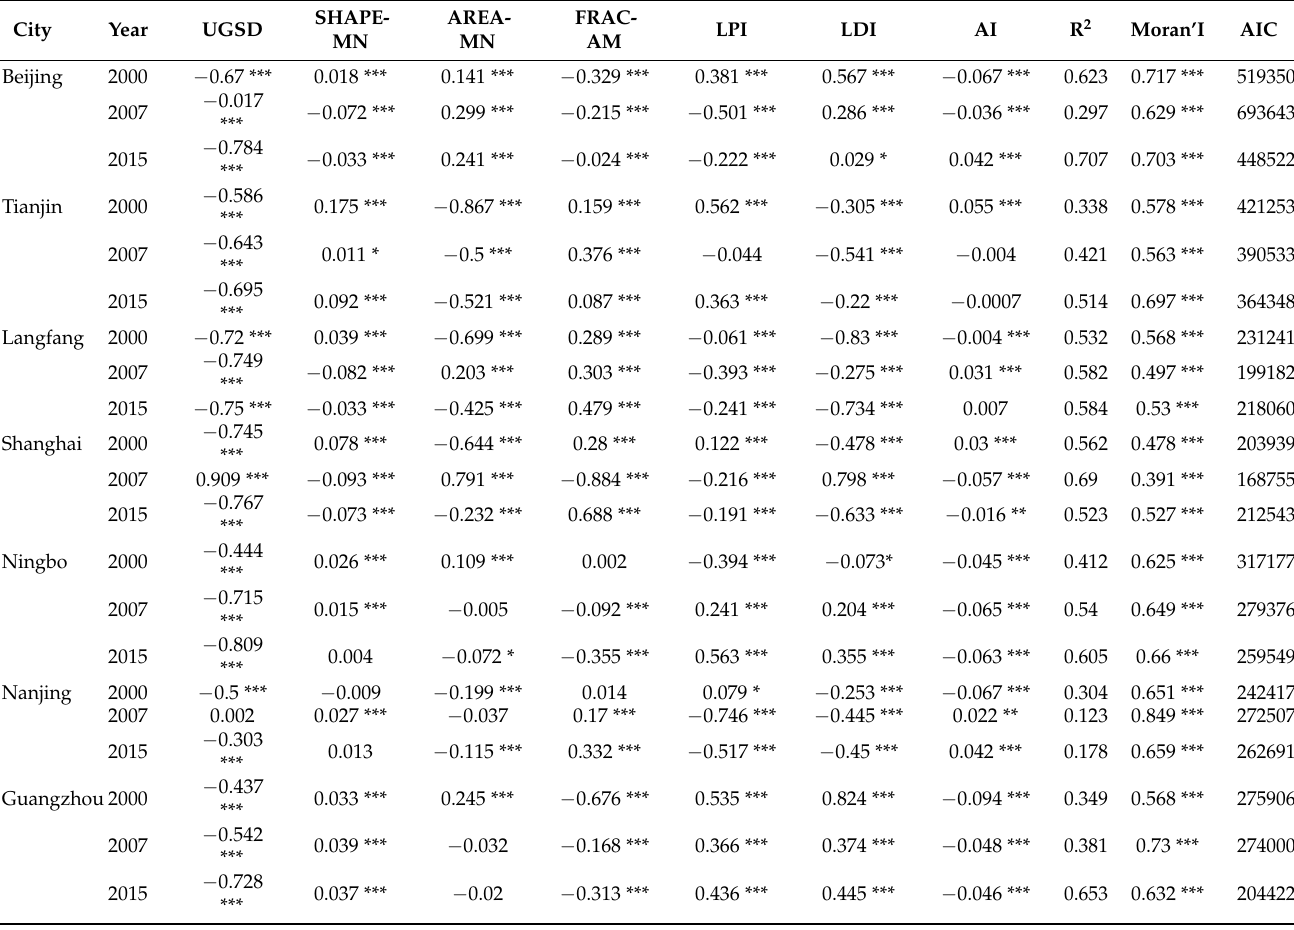
Table A3. The modeling results of the LST, the UGSD and the UGSD landscape configuration metrics within different cities considered in this study from 2000 to 2015. * indicates p < 0.05; ** indicates p < 0.01; *** indicates p < 0.001.